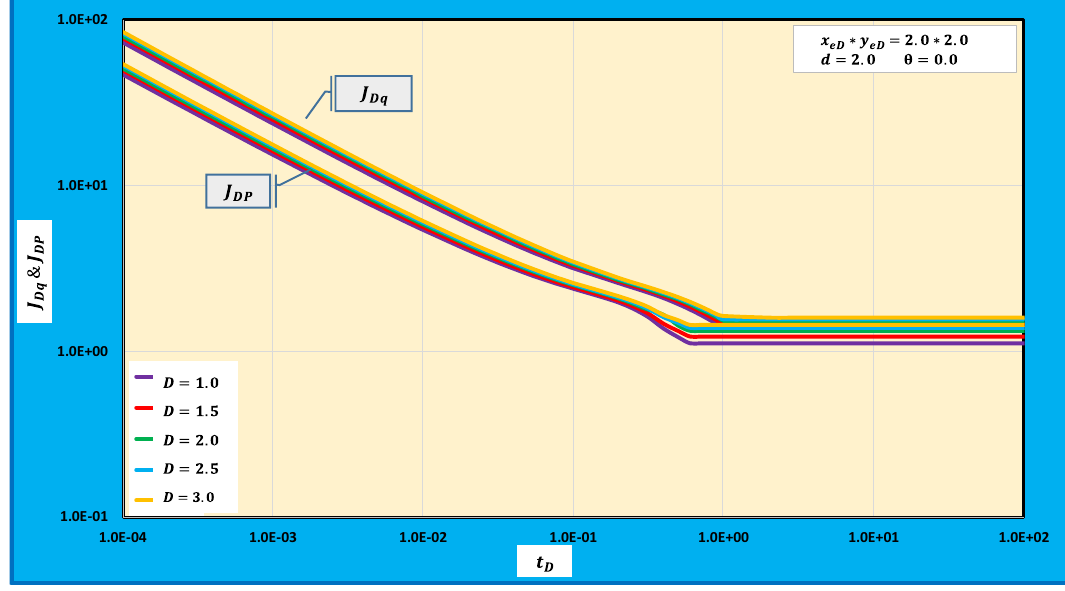
Fig. 17 Productivity index behaviors for different Euclidean dimensions ( 𝜃 = 0.0 )